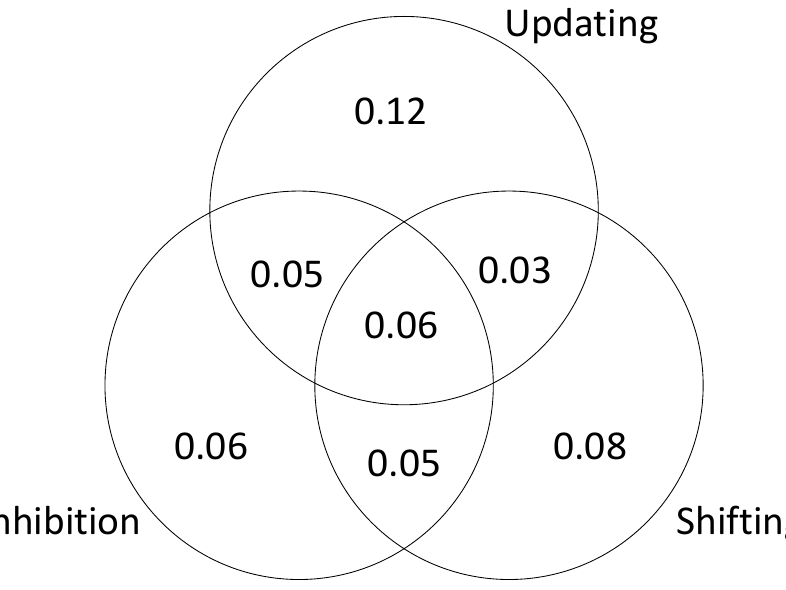
Figure 3. Unique and shared variance in g accounted for by executive attention processes.